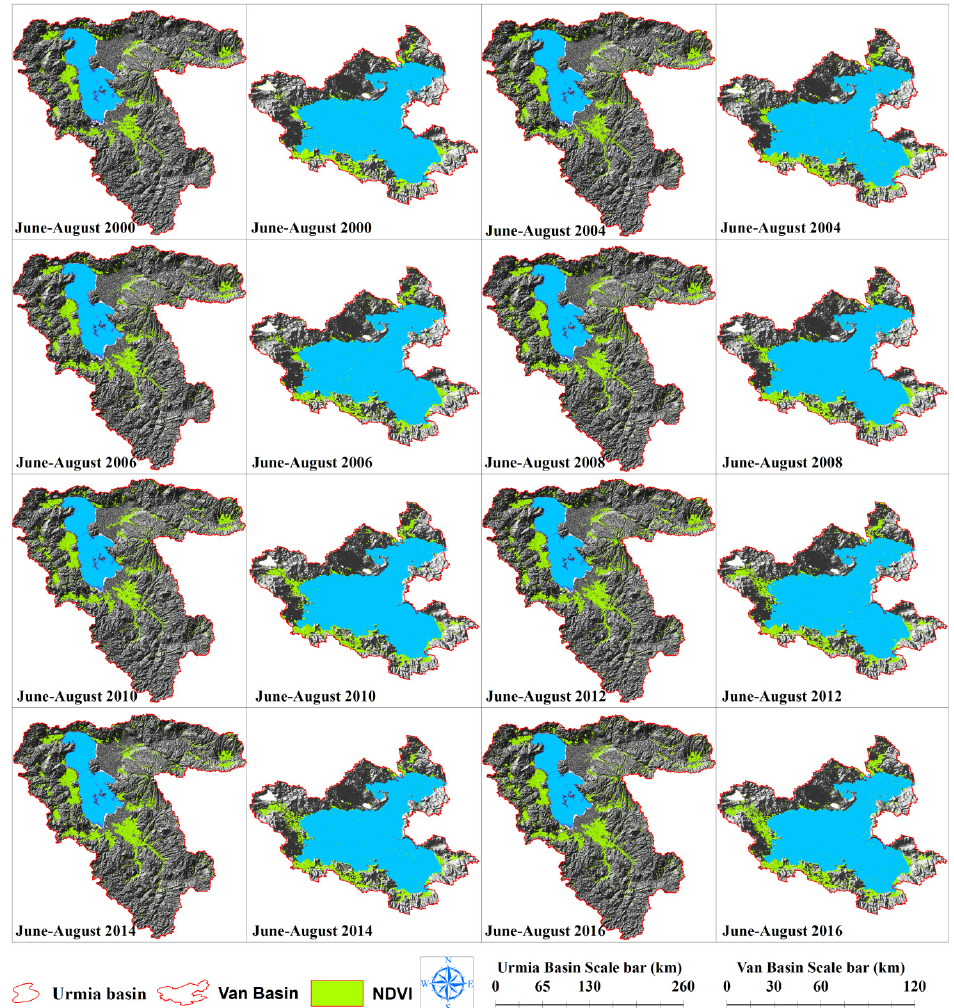
Figure 9. Variations in NDVI values in LU and LV basins from June to August based on MODIS